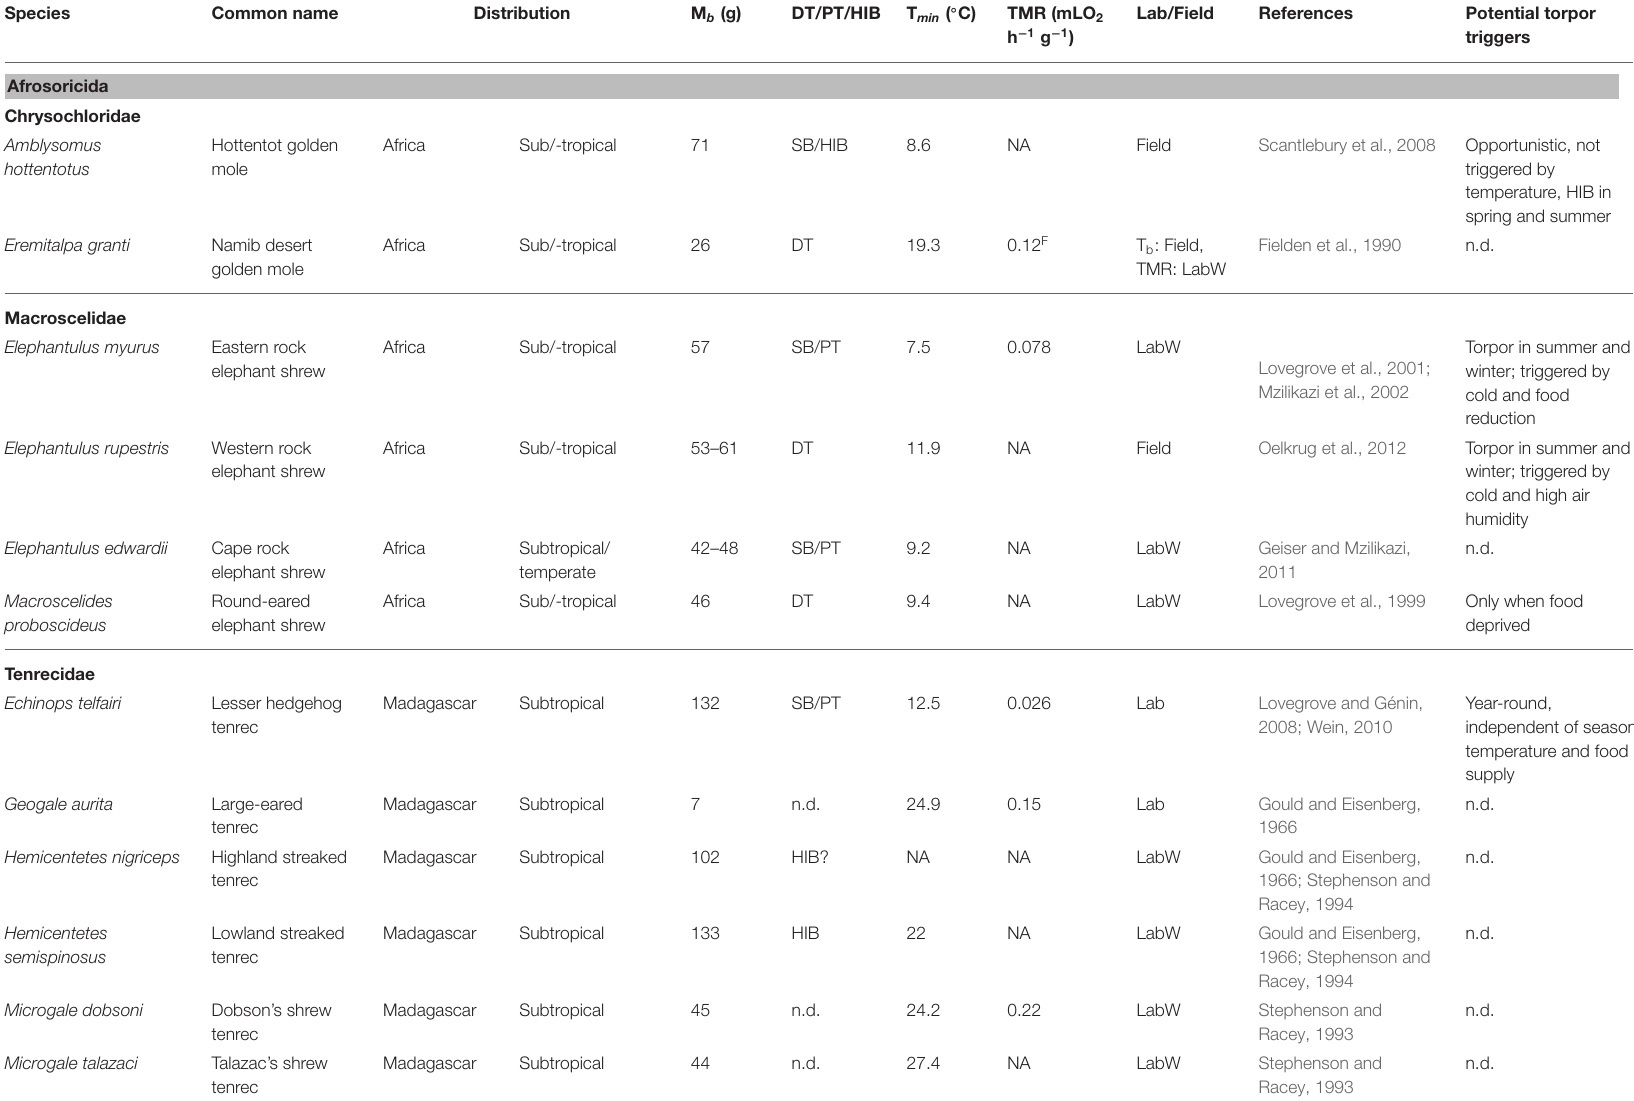
TABLE 1 | Non-Holarctic heterotherms, including species distribution, patterns of heterothermy and potential factors inducing torpor where known.